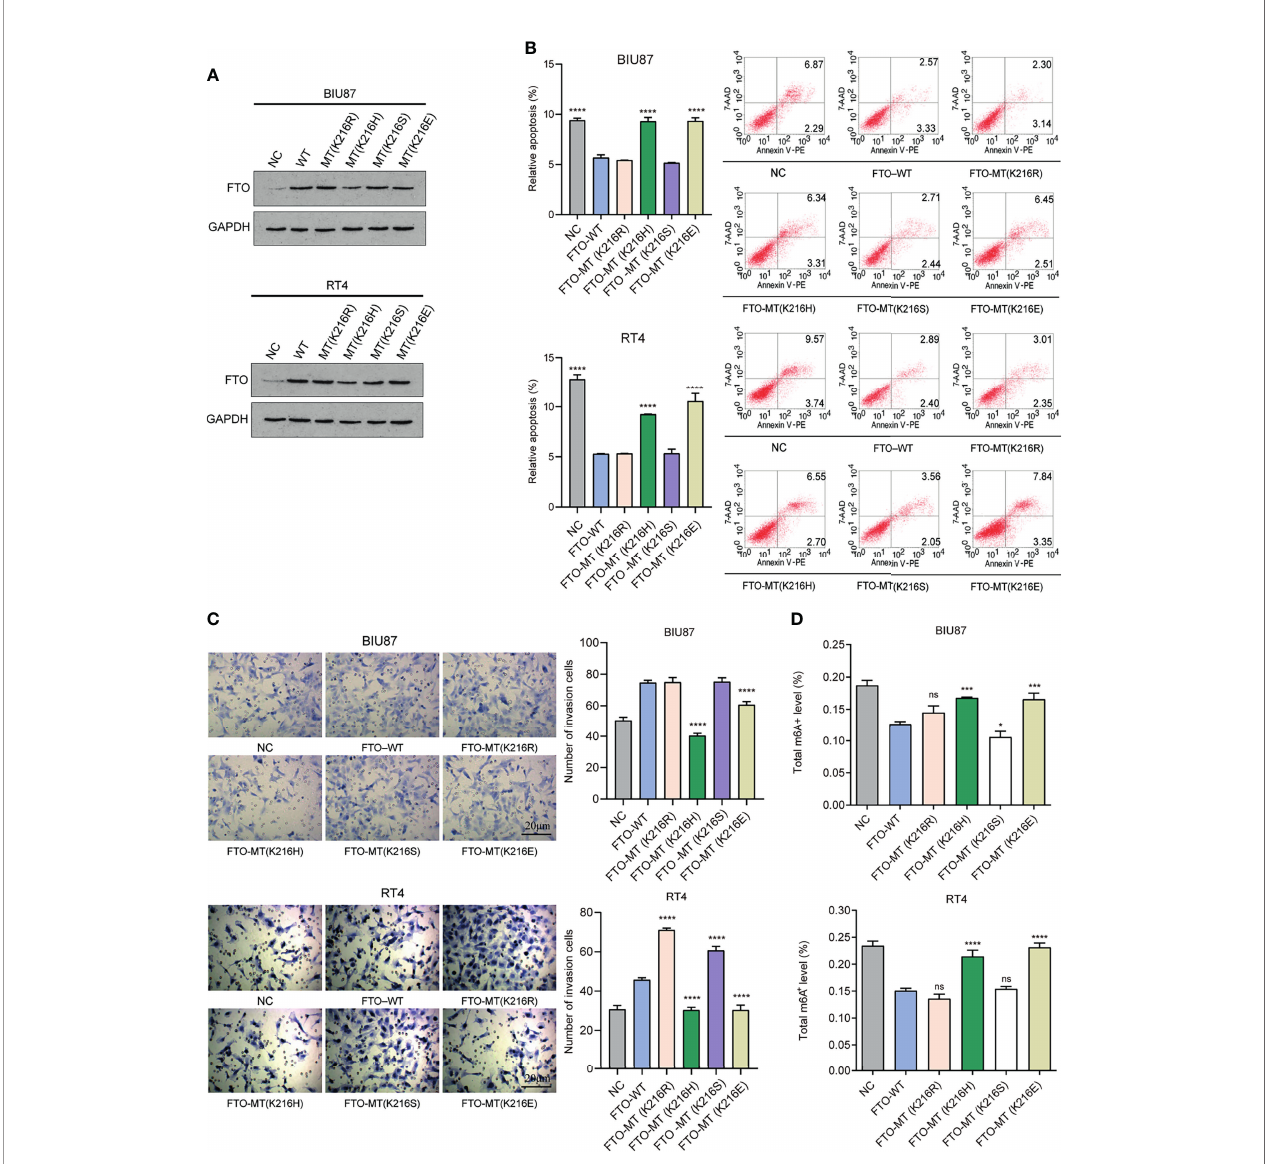
FIGURE 11 | K216H and K216E are the potential important targets for regulating FTO. (A) Western Blot method to detect the expression level of FTO in each group. (B) Flow cytometry method to detect apoptosis in each group of cells. (C) Transwell method to observe the level of cell invasion in each group. (D) Detection of m 6 A enzyme activity in each group. The histogram data for each group is the average of three independent replicates; bars represent mean ± SD; *P < 0.05, ***P < 0.001, ****P < 0.0001, ns P >